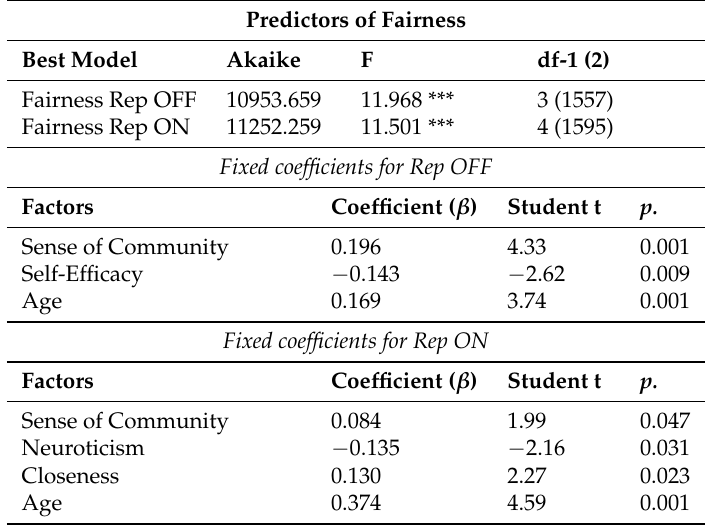
Table 6. GLMM 3. Socio-demographic and Psychological predictors of fair behavior in each